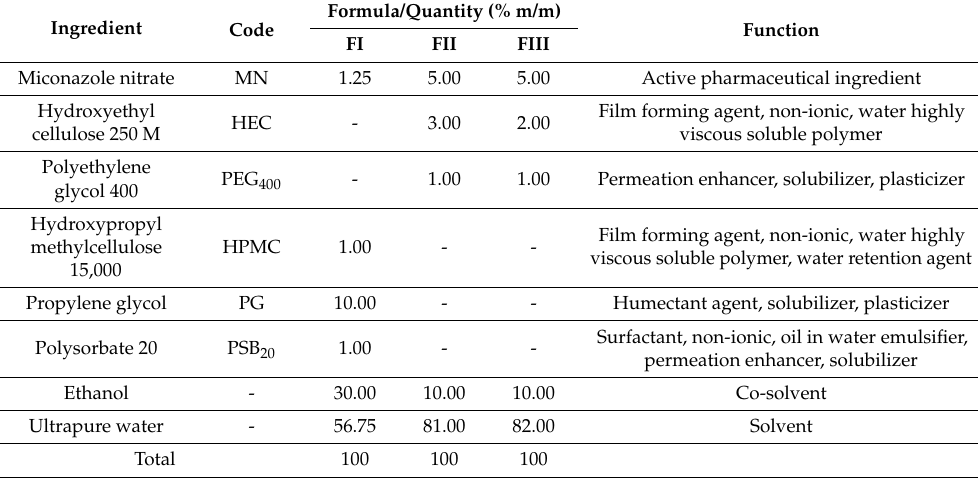
Table 1. Composition of the liquid phases casted to obtain the miconazole nitrate